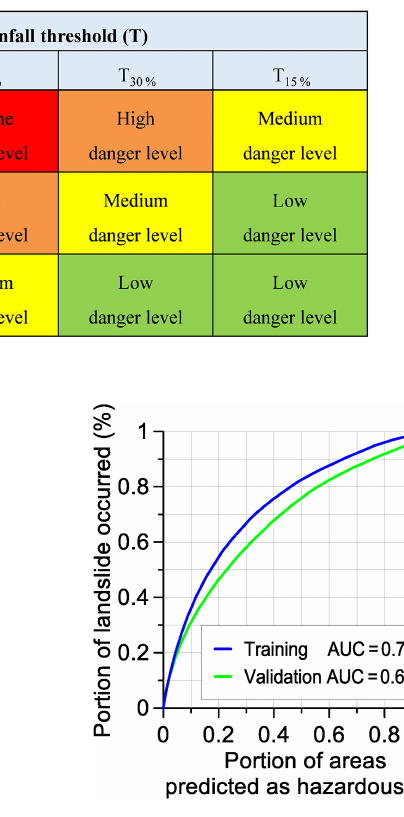
Figure 5. Area under the curve (AUC) of training and validation of landslide susceptibility